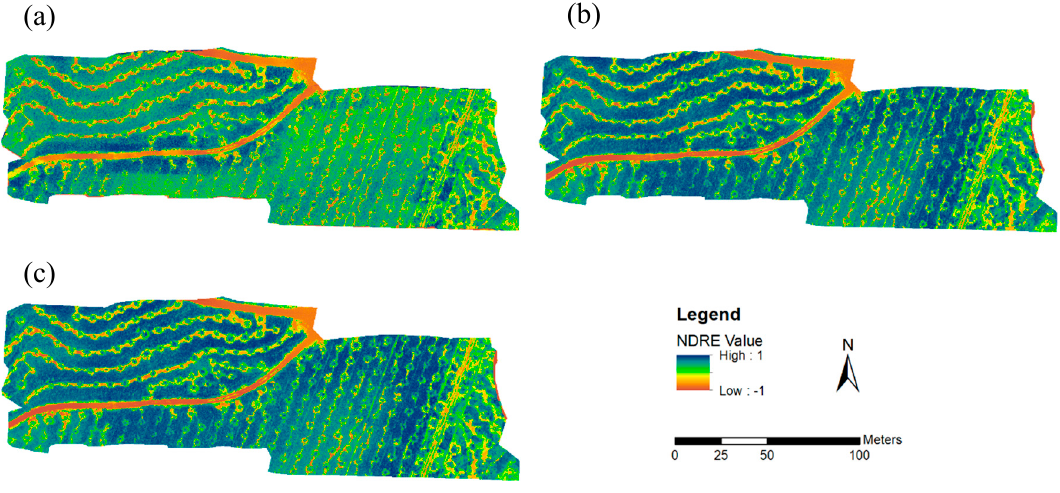
Figure A4. Normalized Difference Red Edge (NDRE) for ( a ) 20 m, ( b ) 60 m and ( c ) 80 m altitude.